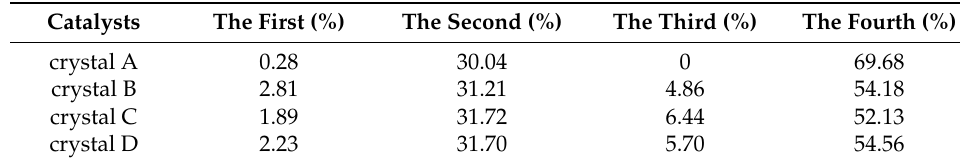
Table 3. The crystals weight loss data from